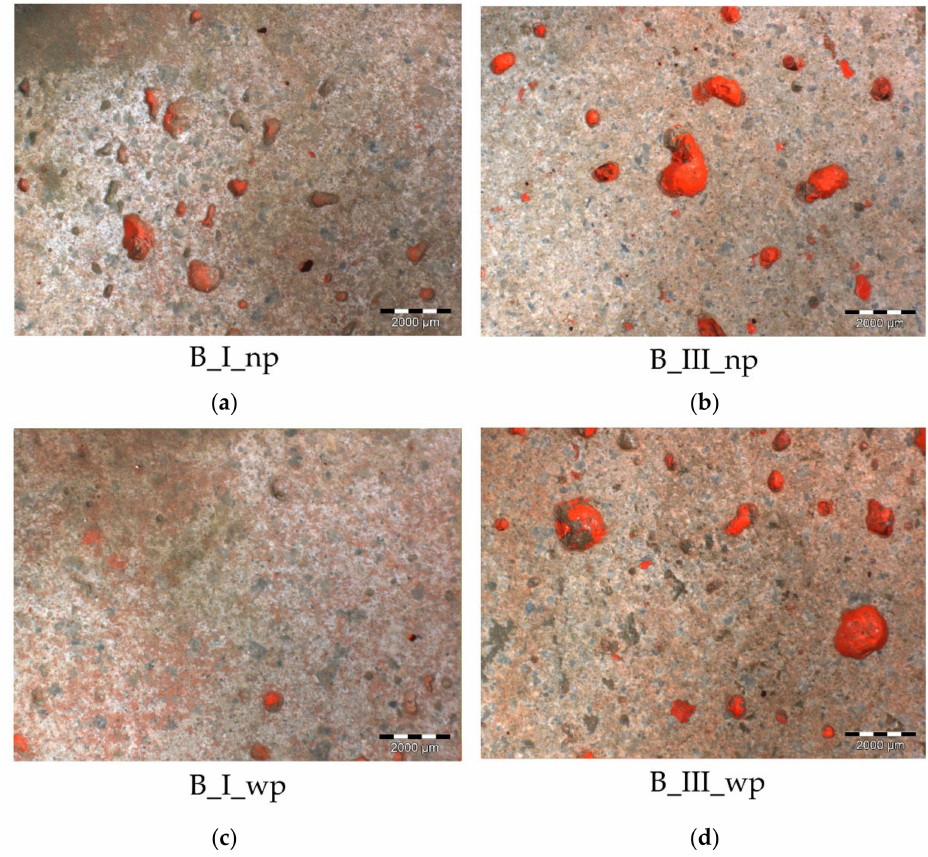
Figure 5. Optical images at 10 × of mock-up A treated with propylene carbonate ( a , c ) and Nanorestore Gel ® for 1 h ( b , d ) on both the unprotected (np) and the protected (wp) area. ( a ) B_I_np; ( b ) B_III_np; ( c ) B_I_wp; ( d )